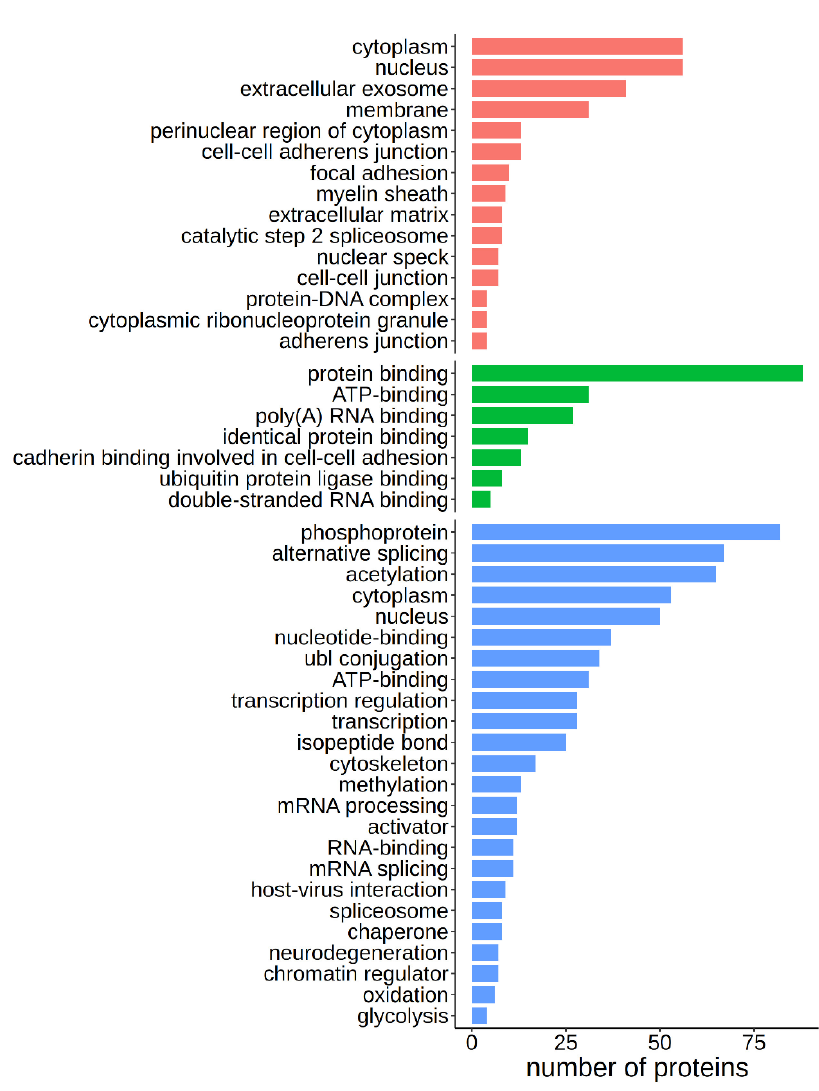
more—are related to regulation of RNA transcription, splicing, and processing, RRFM2 and